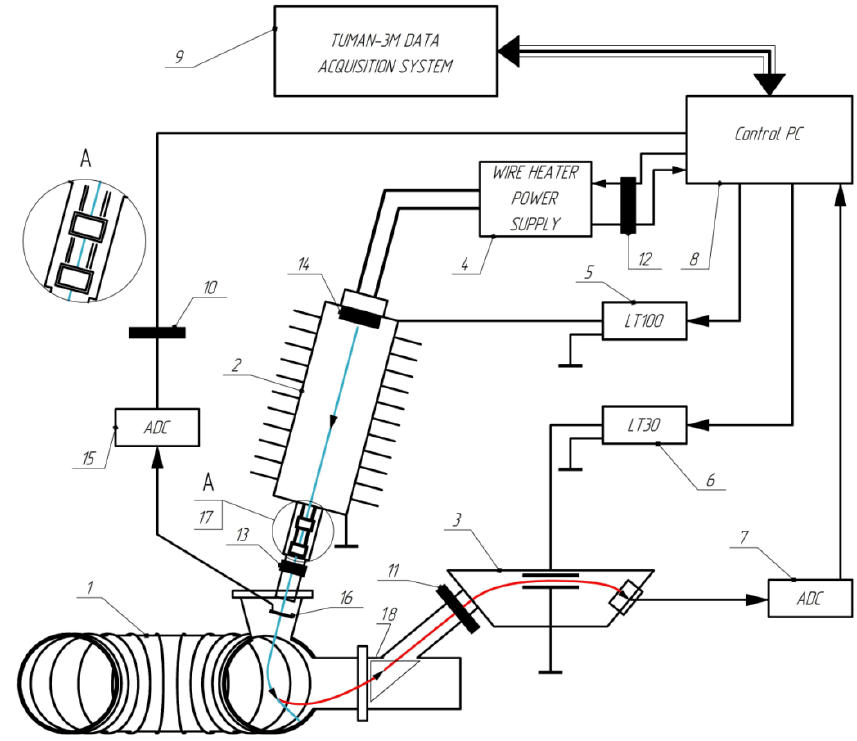
Figure 1. Layout of HIBP diagnostics at the TUMAN-3M tokamak. 1—TUMAN-3M tokamak, 2—Primary beam accelerator, 3—Secondary ion energy analyzer, 4—Autonomous isolated power supply for thermionic source, 5—Accelerator high voltage power supply, 6—Secondary ion energy analyzer high voltage power supply, 7—DAC of secondary ion energy analyzer, 8—Main control PC of HIBP, 9—Data acquisition system of TUMAN-3M tokamak, 10–13–Galvanic isolation modules, 14—Thermionic source of primary ions, 15—DAC of primary beam wire array detector, 16—Primary beam wire array detector, 17—Primary beam steering plates box, 18—Secondary beam steering plates box.